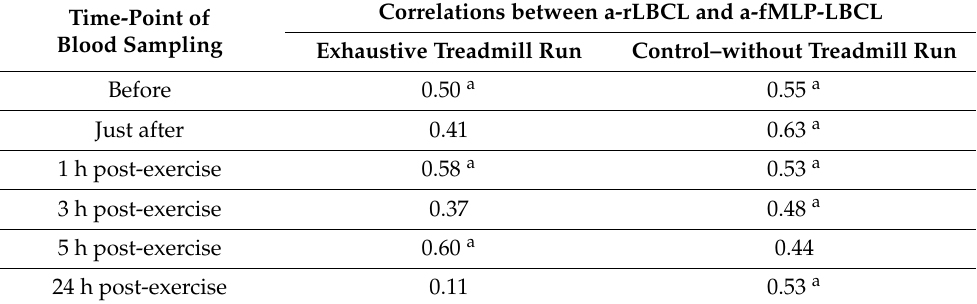
Table 11. Correlations ( δ ) between a-rLBCL and a-fMLP-LBCL of samples collected before, just after and at 1 h, 3 h, 5 h and 24 h post-exhaustive treadmill